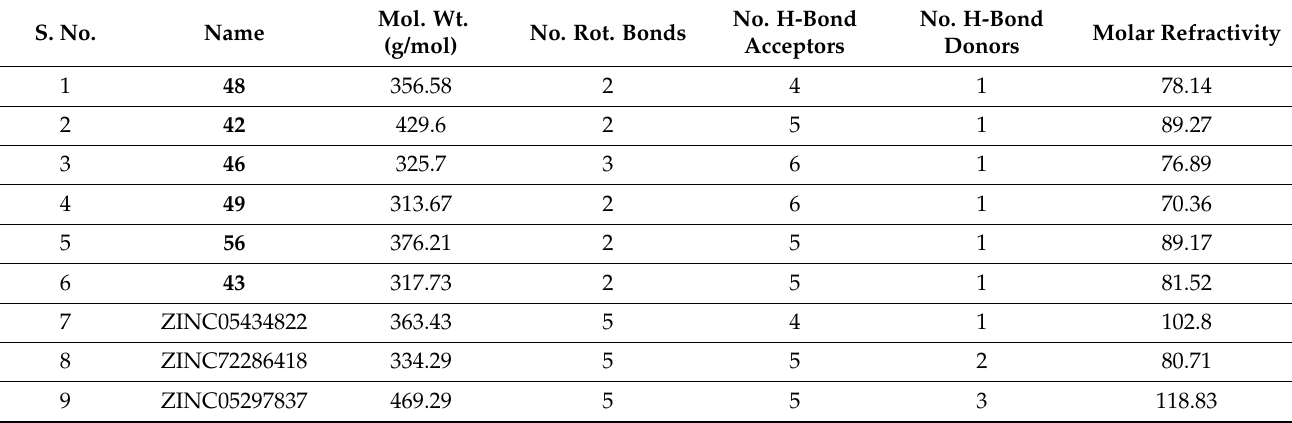
Table 9. Physicochemical property prediction of ZINC database and other active compounds. S. No.